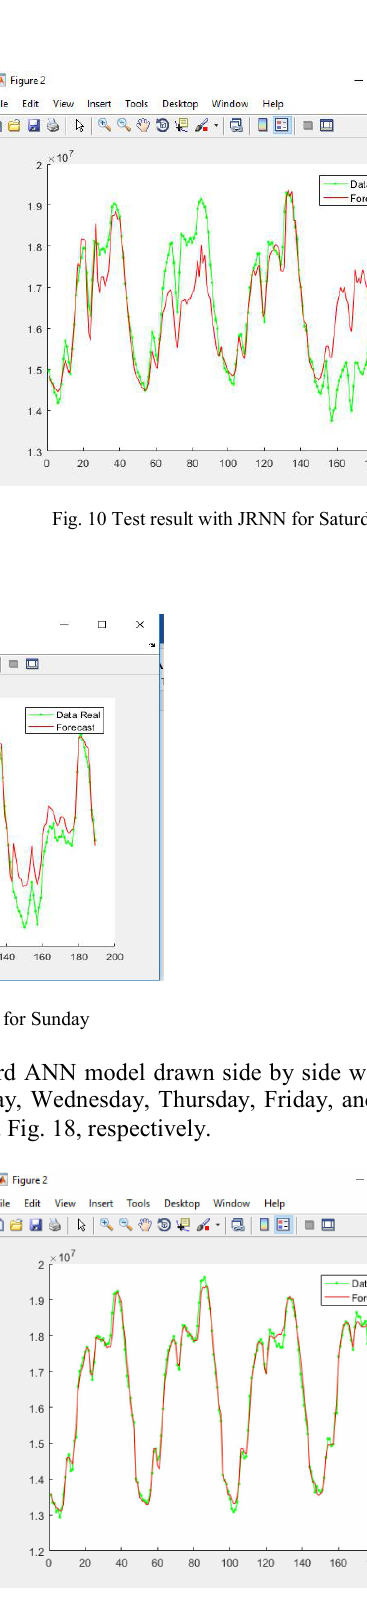
Fig. 12 Test result with traditional feed forward ANN for Monday